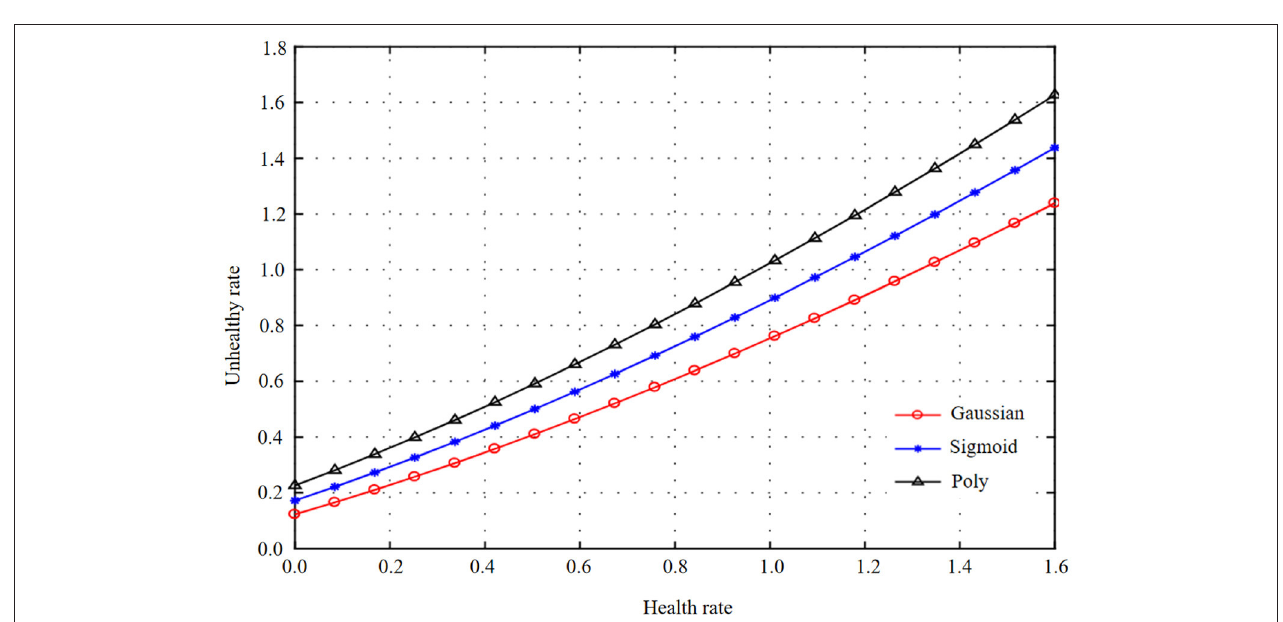
FIGURE 4 | Health information statistics of logistic regression combined data and basic data.